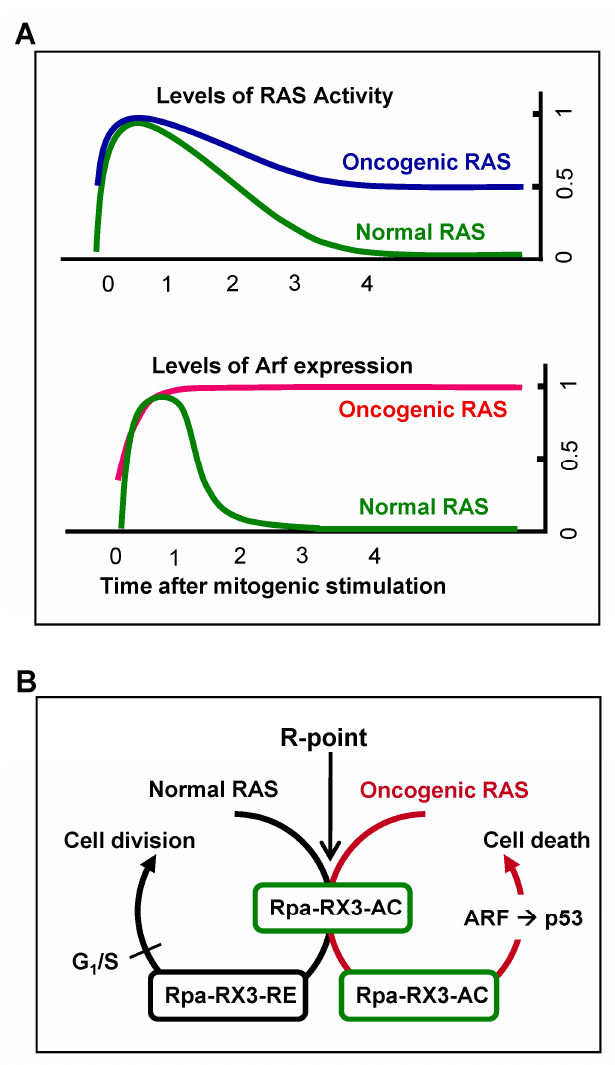
Figure 5. Mechanism for sensing constitutive RAS activation. ( A ) Normal RAS activity is downregulated to the basal level soon after mitogenic stimulation. While RAS is activated, ARF is expressed. In normal cells, ARF is expressed for only a short time (1–3 h after mitogenic stimulation), followed by its suppression when RAS activity is downregulated. However, heterozygous mutations of RAS result in the maintenance of 50% of the maximum level of RAS activity. This persistent RAS activity maintains ARF expression until the G 1 /S checkpoint is reached. ( B ) Schematic illustration of the R-point-associated oncogene surveillance mechanism. Formation of the Rpa-RX3-AC complex is triggered by the RAS-MEK pathway 1 h after serum stimulation. The complex binds to the ARF promoter through RUNX-binding sites and induces ARF expression. After the R-point (4 h after mitogenic stimulation), the RAS-MEK pathway activity is downregulated. Rpa-RX3-AC complexes are converted to Rpa-RX3-RE complexes, which suppress ARF expression. However, constitutively activated RAS signaling inhibits the conversion of Rpa-RX3-AC to Rpa-RX3-RE complexes and prolongs ARF expression, which drives cells toward apoptosis. These series of molecular events enable cells to distinguish normal mitogenic signals from abnormal oncogenic K-RAS signals, thereby constituting an R-point-associated oncogene surveillance mechanism.